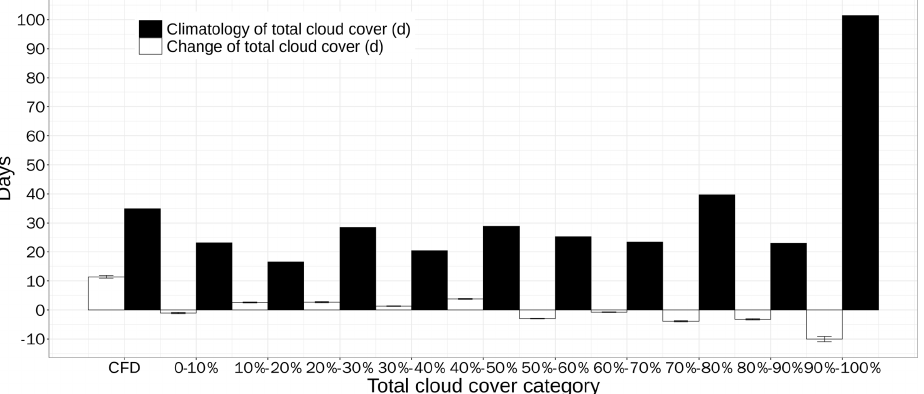
Figure 8. Climatology (units: days) and changes (units: ddecade − 1 ) in the cloudy days falling within each bin during 1957–2005. CFD denotes cloud-free days and 0%–10% denotes days of cloud cover within the range of (0%–10%). The vertical line on top of each white bar denotes 1 standard